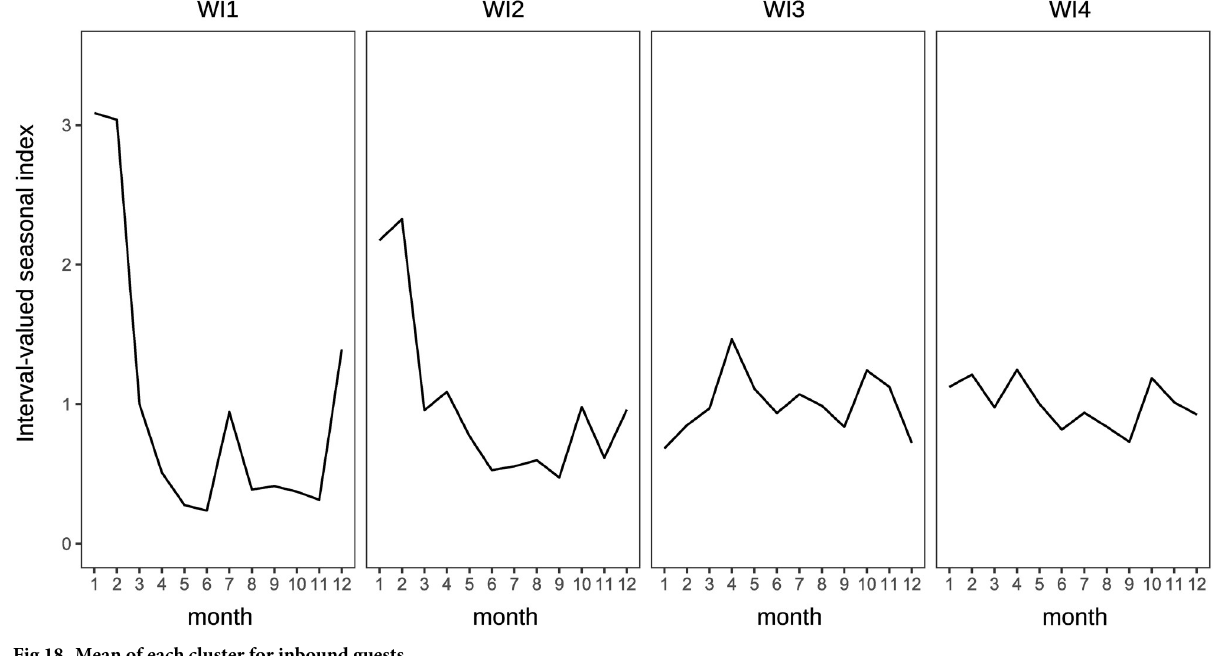
Fig 18. Mean of each cluster for inbound